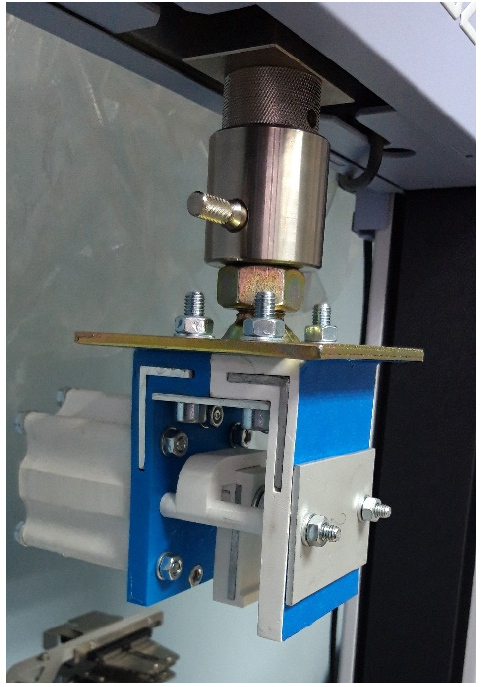
Figure 8. Fully assembled pneumatic cylinder with the jaws and mounted on the tensile testing machine.